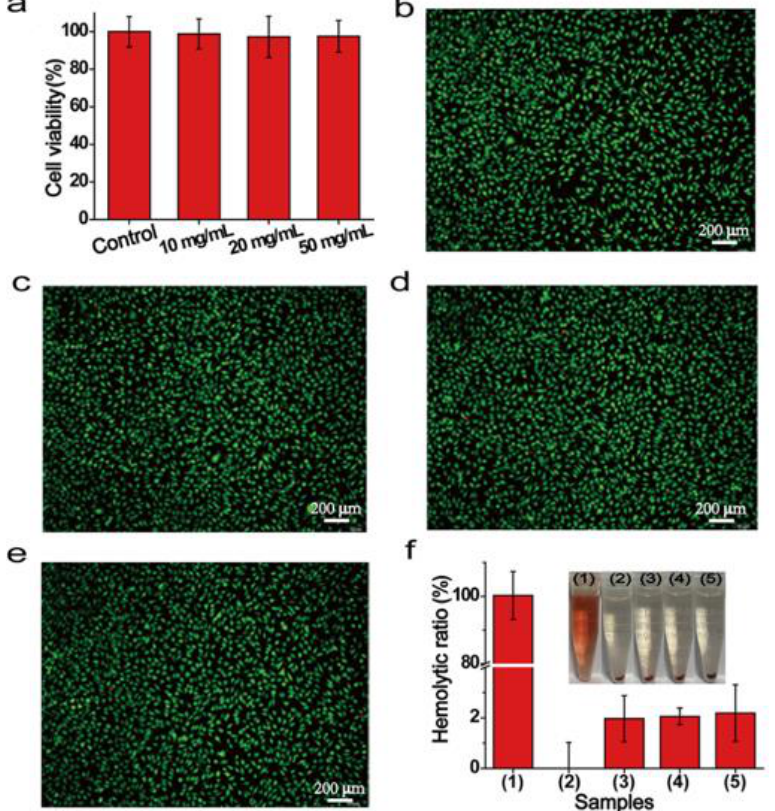
Figure 5. The safety of chitosan/polyaniline/laponite (COL) hydrogel in vitro. ( a ) Mouse fibroblasts (L929) cell viabilities after being cultured with COL hydrogel. Photographs of Live/Dead staining of cells in ( b ) control group, ( c ) 10 mg/mL hydrogel, ( d ) 20 mg/mL hydrogel, and ( e ) 50 mg/mL hydrogel. ( f ) Hemolysis ratios of mouse red blood cells (RBCs) cultured with COL hydrogel; the inset is the corresponding centrifuged mRBC photograph ((1): deionized (DI) water; (2): phosphate buffer solution (PBS); (3): 10 mg/mL hydrogel; (4): 20 mg/mL hydrogel; and (5): 50 mg/mL hydrogel).